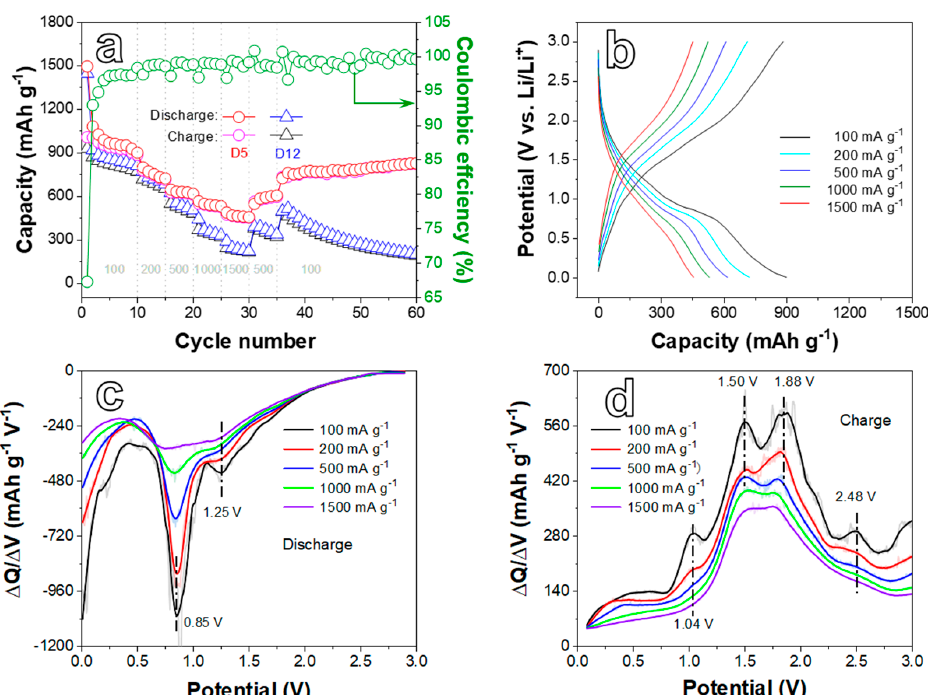
Figure 5. ( a ) Rate performances of D5 and D12 electrodes at different current densities. ( b ) Galvanostatic charge/discharge curves at 100, 200, 500, 1000, and 1500 mA g − 1 of the D5 electrode, corresponding to the rate tests after five formation cycles at every current density. Differential capacity plots of the D5 electrode in the process of ( c ) Discharge and ( d ) Charge processes toward Figure